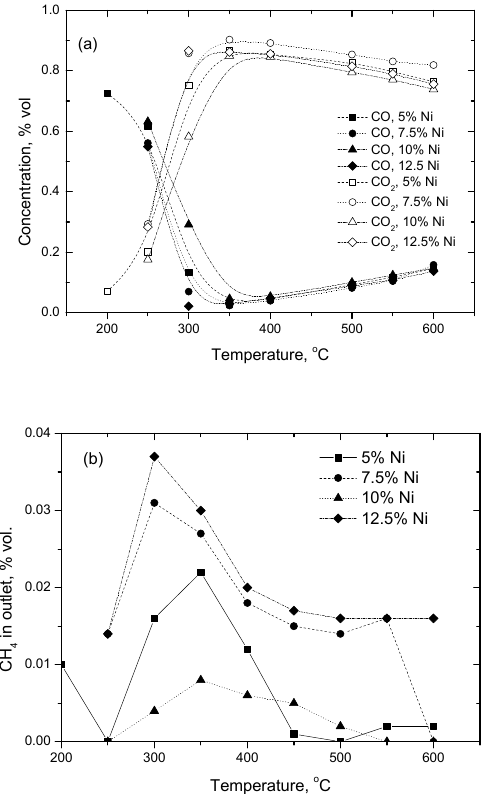
Figure 4. Catalytic performance of Ni/CeO 2 catalysts with different nickel loading in WGS reaction with the feed 1% CO + 1.8% H 2 O in He: ( a ) concentrations of CO and CO 2 ; ( b ) concentration of CH 4